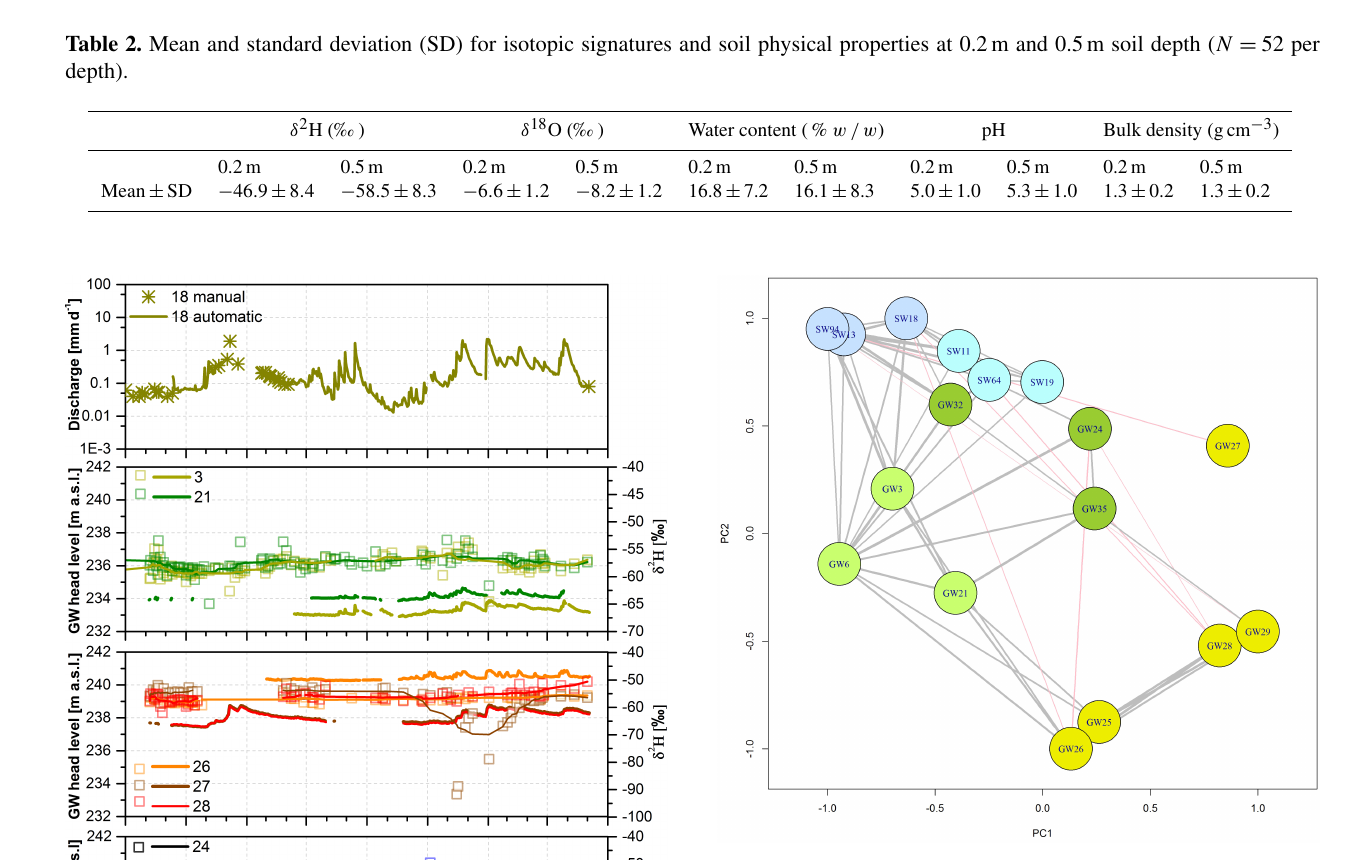
Figure 9. Network map of δ 18 O relationships between surface wa- ter (SW) and groundwater (GW) sampling points. Yellow circles represent groundwater sampling points on the arable field, light green circles are piezometers located on the grassland close to the conjunction of the Schwingbach with the Vollnkirchener Bach, and dark green circles represent piezometers along the Vollnkirchener Bach. Light blue circles stand for Schwingbach and darker blue circles for Vollnkirchener Bach surface water sampling points. See Fig. 1 for an overview of all sampling points. Only statistically sig- nificant connections between δ 18 O time series ( p <0.05) are shown in the network